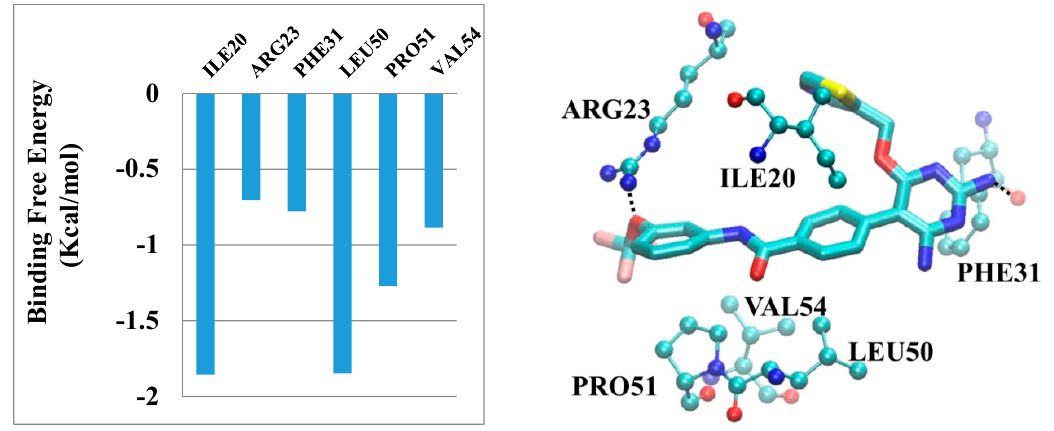
Figure 4. Left : The residues whose binding free energy contributions are greater than − 0.5 Kcal/mol; Right : The interactions between key residues and compound 16l .